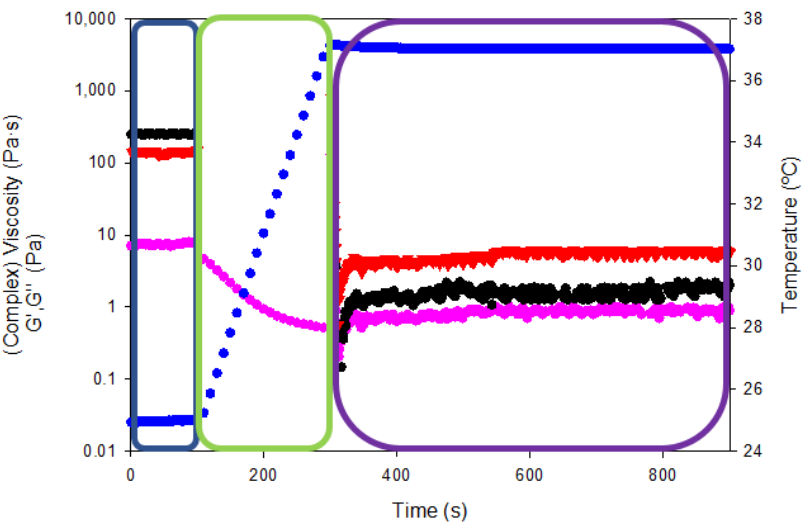
Figure 14. Rheological curves as a function of temperature and intra-articular injection stage (shear